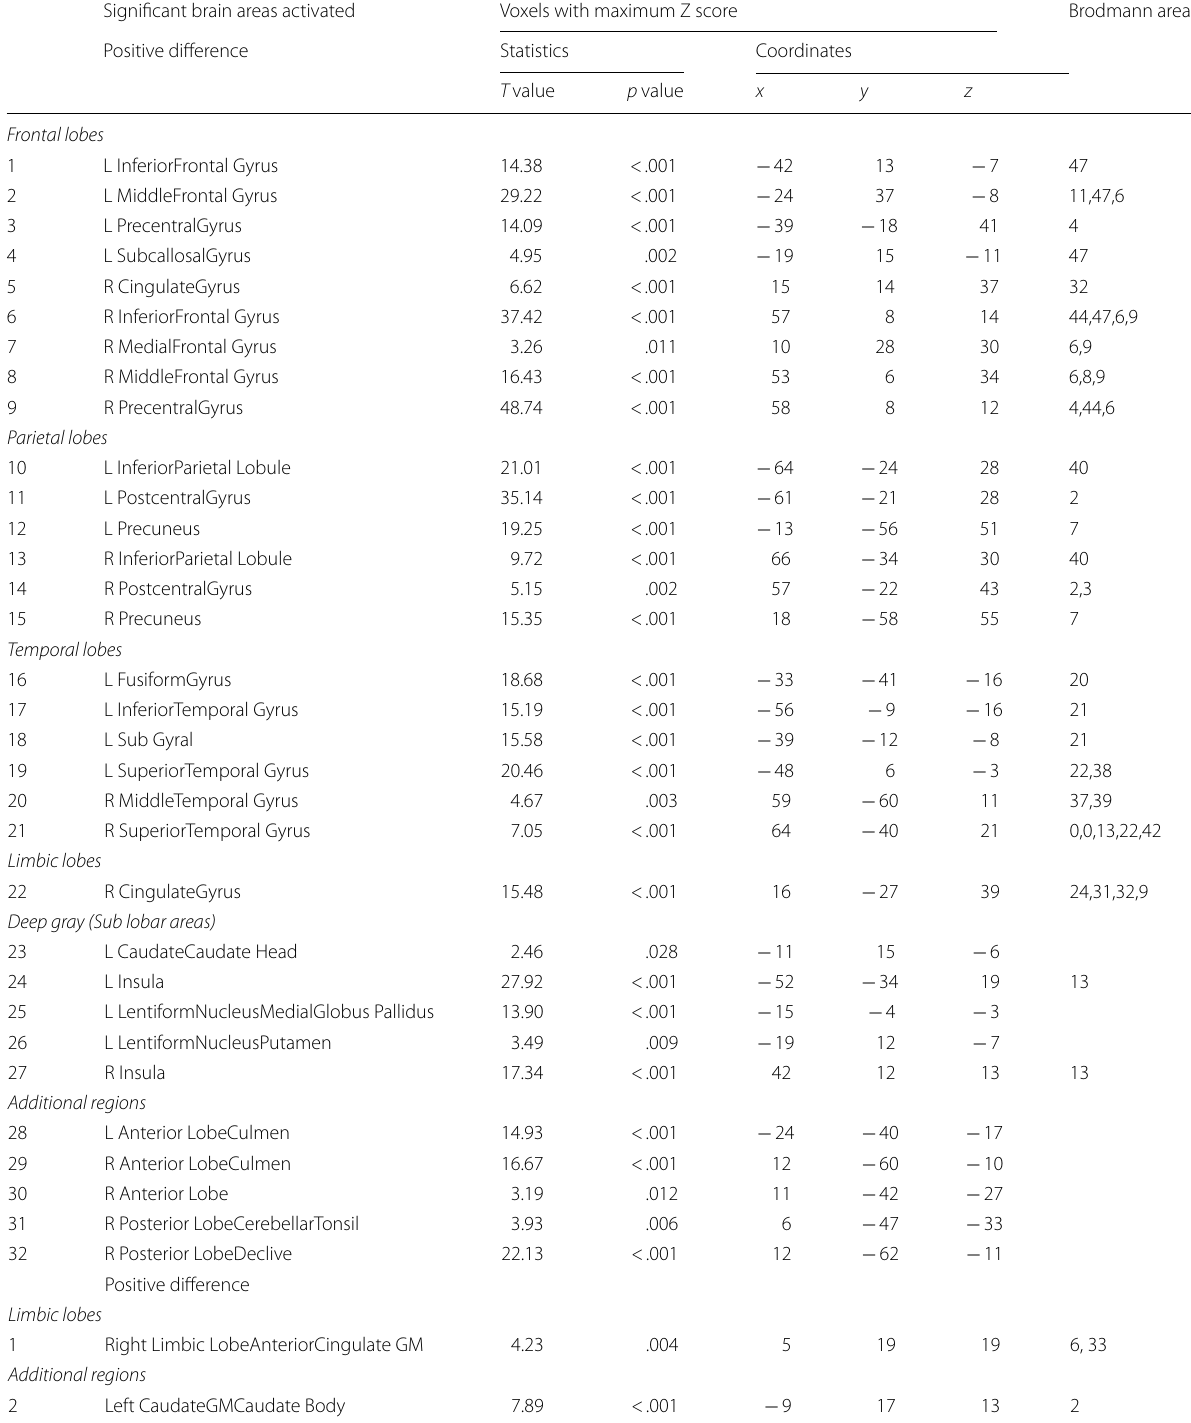
Anatomical labels and associated T statistical values are listed. T scores from the omnibus analyses of 6 participants for each ROI are